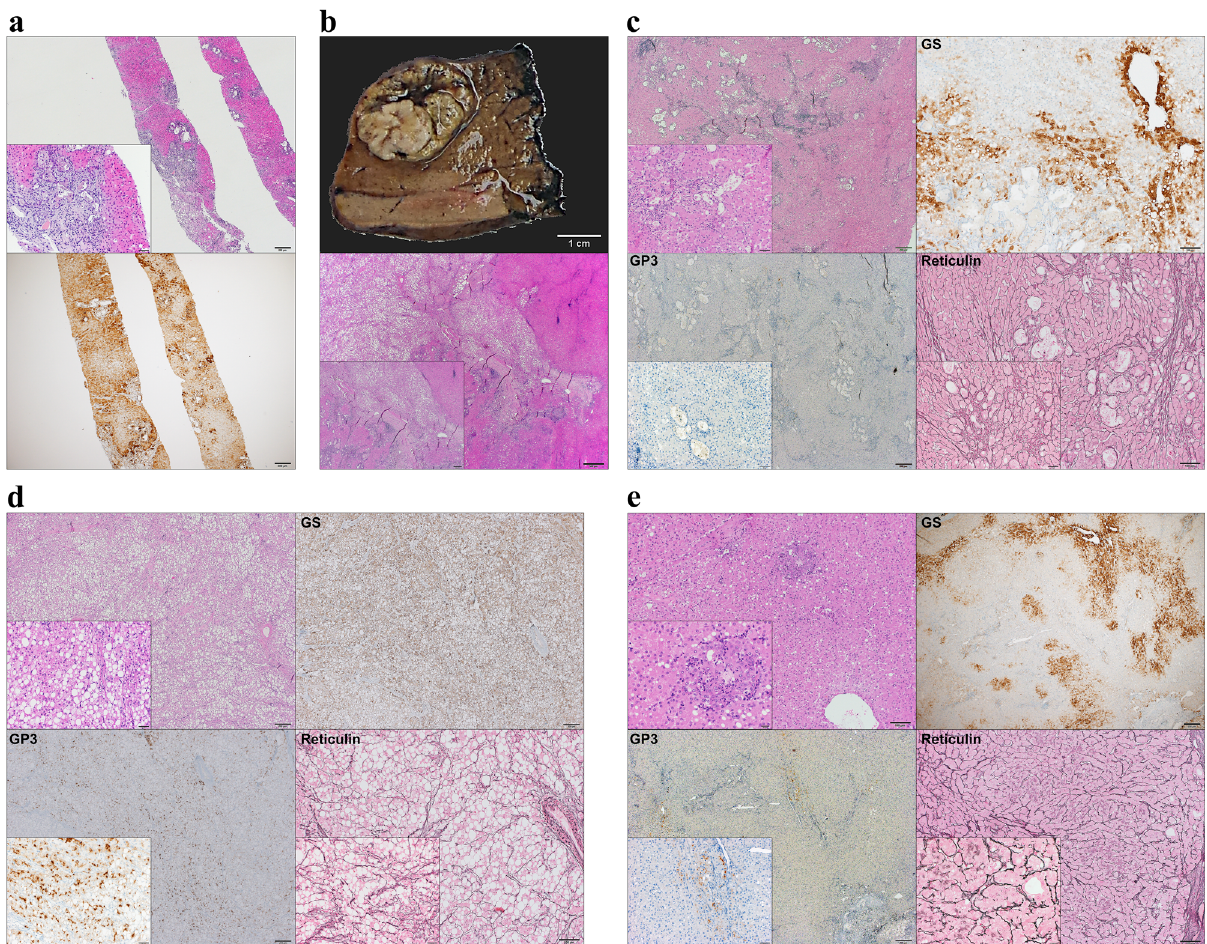
Fig. 2 Histopathological characterization of the Focal Nodular Hyperplasia (FNH) and Hepatocellular Carcinoma (HCC). a Hematoxylin and eosin (H&E) staining in the diagnostic biopsy (liver segment 6) shows hyperplastic tissue with dilated bile duct proliferation (scale bar 200 μ m; insert 50 μ m). Glutamine synthetase (GS) staining positive was a “ map-like ” pattern (scale bar 200 μ m). b The nodule macroscopically consists of two different components (scale bar 1 cm). H&E staining of the nodule showed two different HCC components adjoining the FNH nodule (scale bar 500 μ m; insert 200 μ m). c Histological analysis of FNH showing classical features of FNH, such as nodular formation and fi brous septa with abnormal vessels (scale bar 200 μ m; insert 50 μ m). GS staining displayed the typical “ map-like ” pattern consistent with the diagnostic biopsy (scale bar 100 μ m; insert 50 μ m). Glypican 3 (GPC3) staining was negative (scale bar 200 μ m; insert 50 μ m), the reticulin framework was preserved (scale bar 100 μ m; insert 50 μ